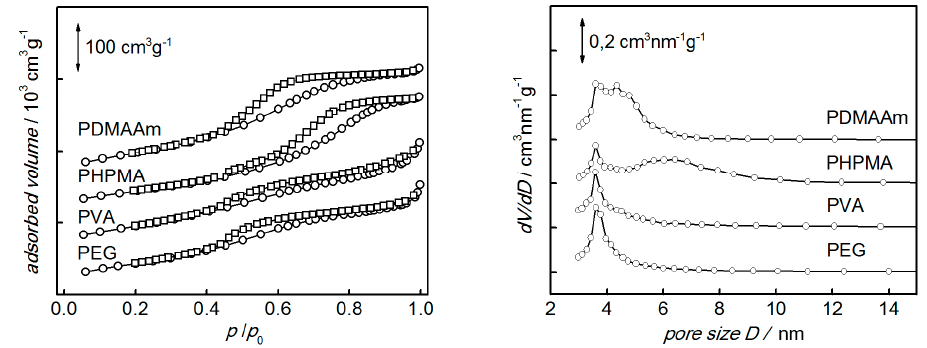
Figure 3. N 2 physisorption isotherm ( left ) and pore size distribution ( right ) of mesoporous γ -Al 2 O 3 prepared using various polymers as the porogenic structure matrices as indicated. (Data are vertically shifted for clarity). Table 2. Specific Brunauer–Emmett–Teller (BET) surface areas A BET , pore volumes V , and mean pore widths r obtained from N 2 physisorption of mesoporous alumina synthesized using various polymers.